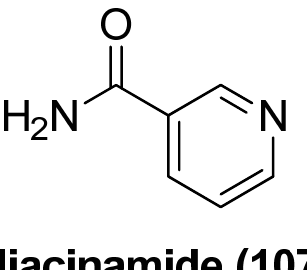
Figure 27. Chemical structure of niacinamide